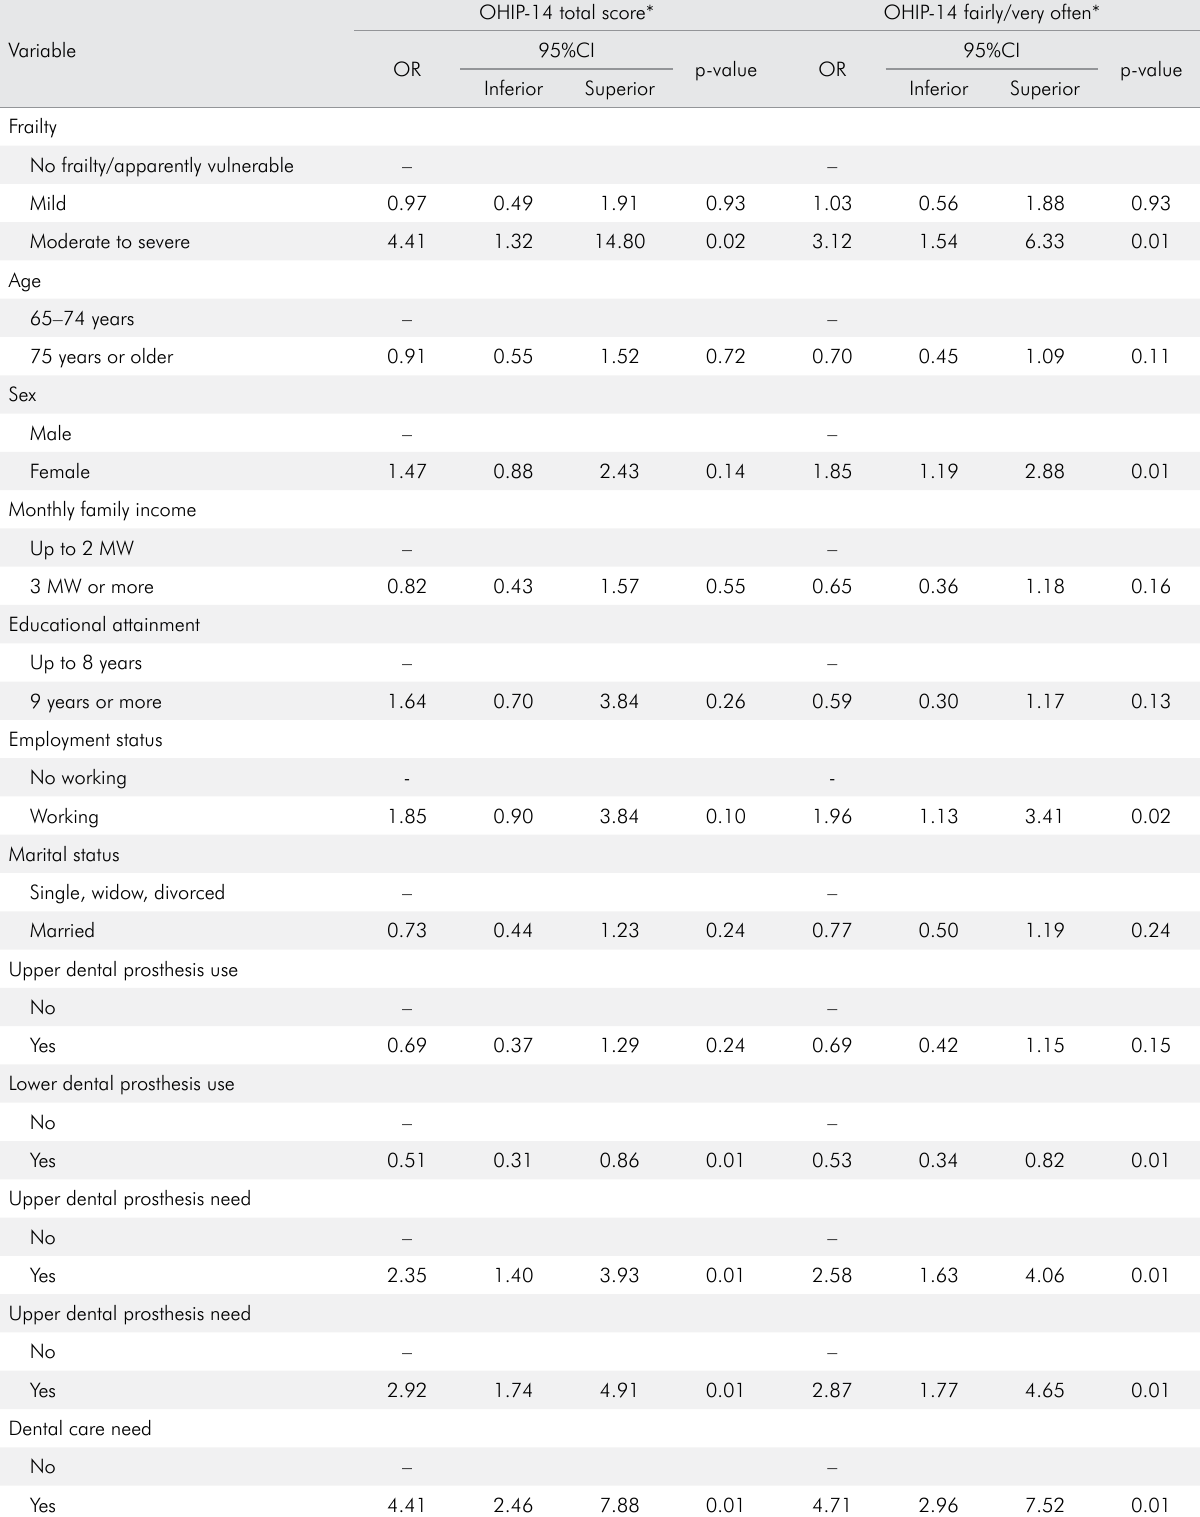
Table 3. Unadjusted logistic regression analysis for the association between frailty, sociodemographic characteristics, dental clinical measures, and self-perceived dental care needs and oral health-related quality of life in community-dwelling older